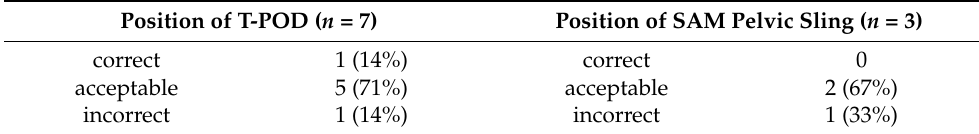
Table 4. PCCD type (T-POD or SAM Pelvic Sling) in unstable